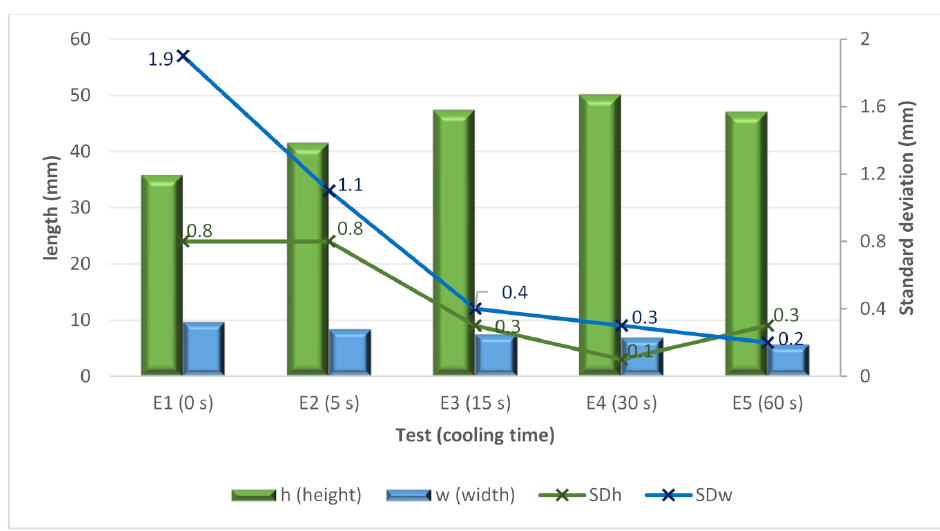
Figure 11. Height, width and standard deviation versus the E samples.